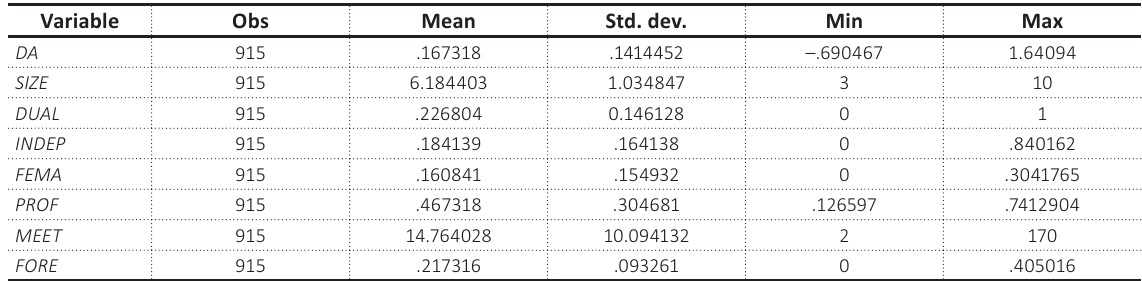
Table 3. Correlation